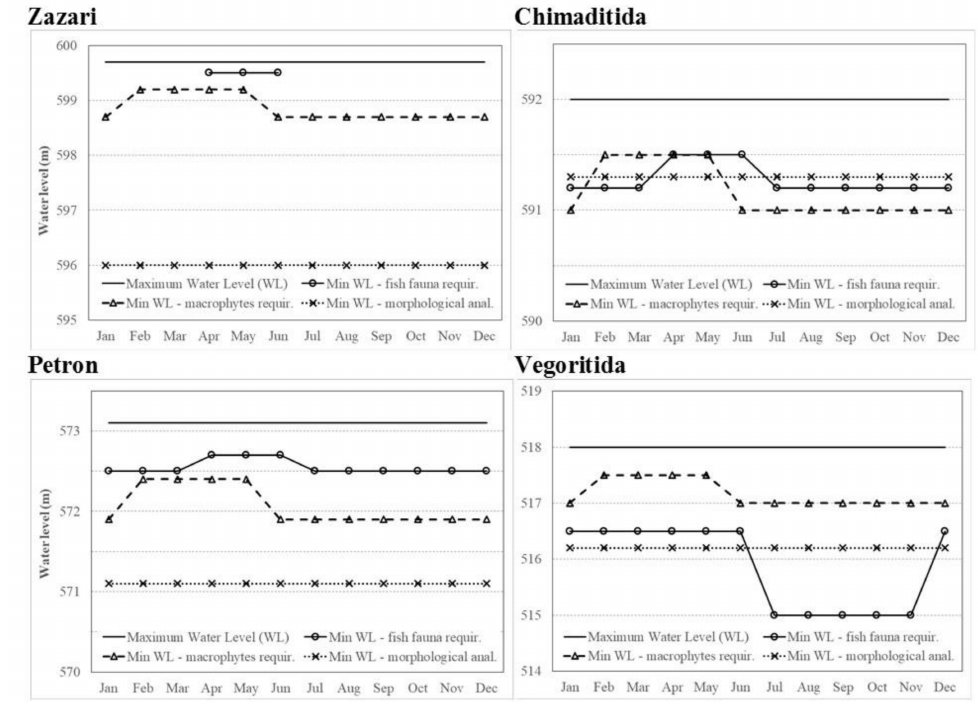
Figure 5. Proposed minimum water level based on the morphological analysis and the requirements of macrophytes and fish in Lakes Zazari, Chimaditida, Petron, and